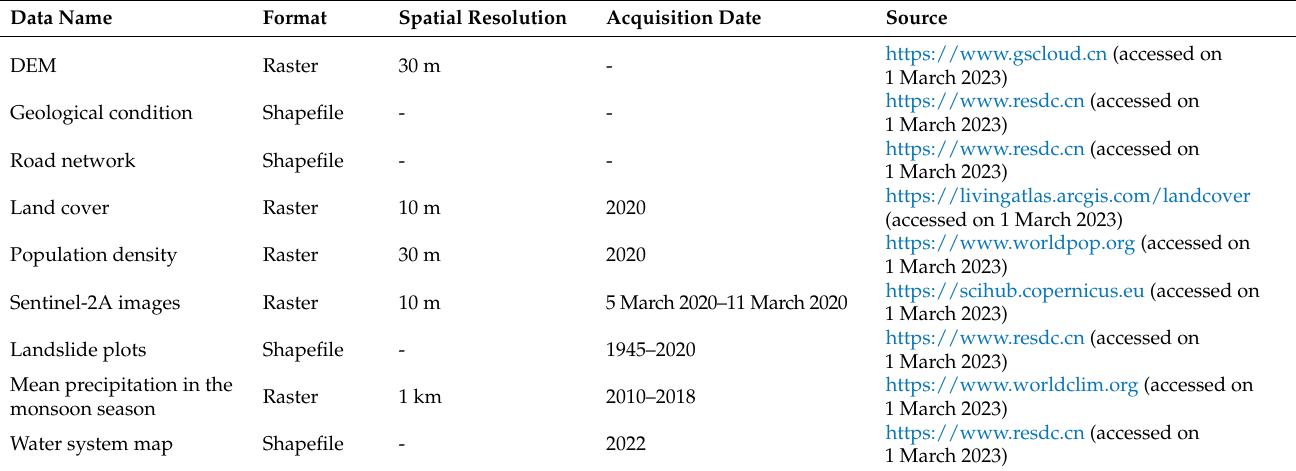
Table 1. Data sources, format and other